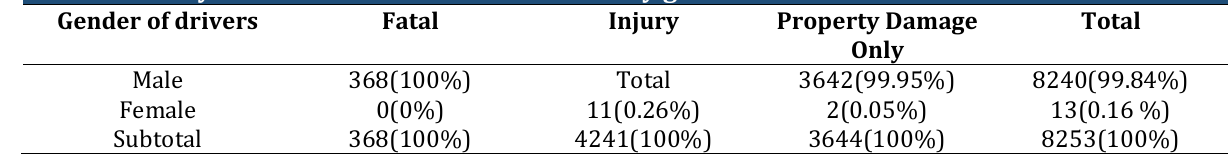
Table 3: Heavy vehicle crash count distribution by gender Gender of drivers Fatal